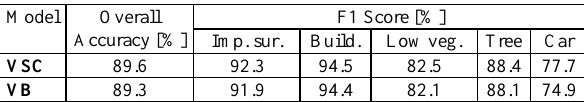
Table 3. Results for Vaihingen benchmark.